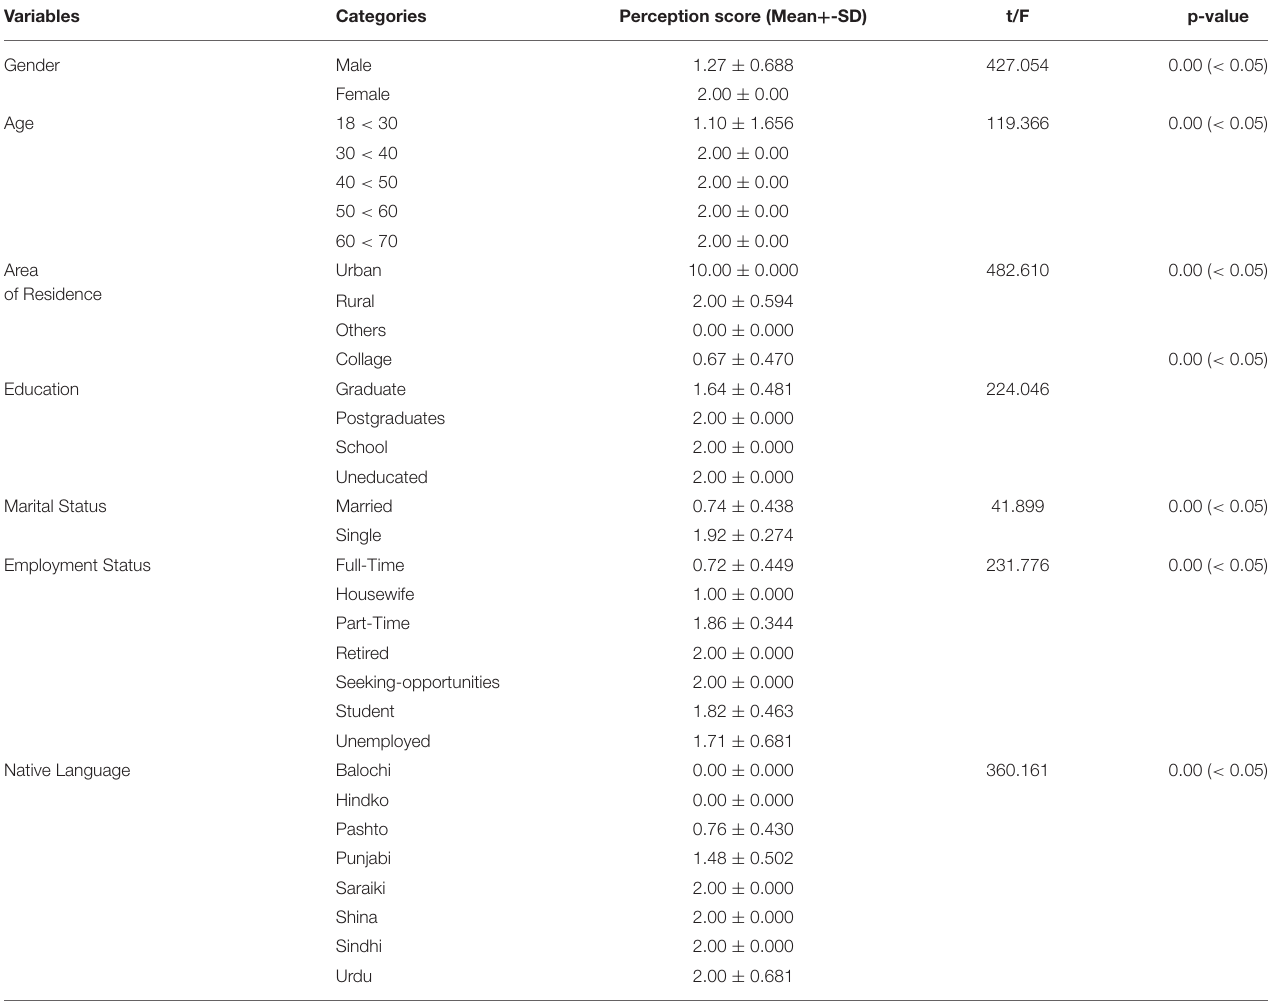
TABLE 5 | Association of perception with demographic variables of respondents ( N = 734).